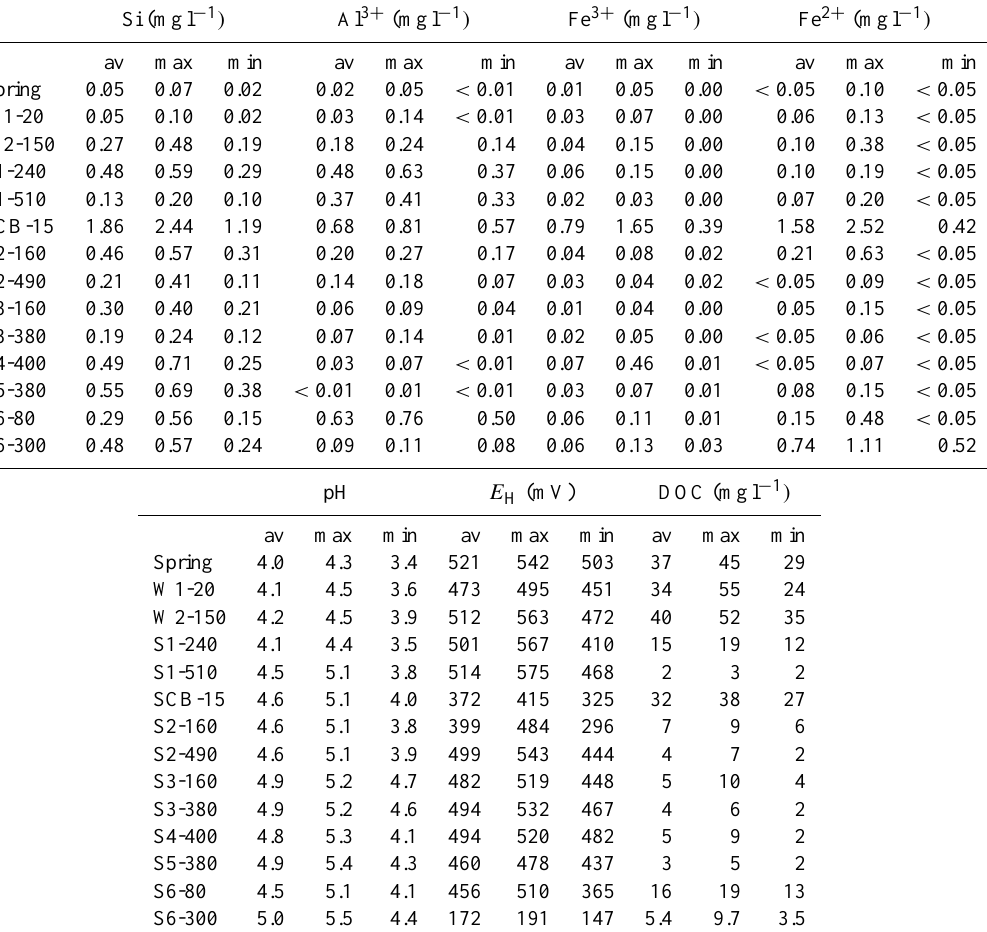
Table 2. Summary of the composition of the groundwater for each sampling